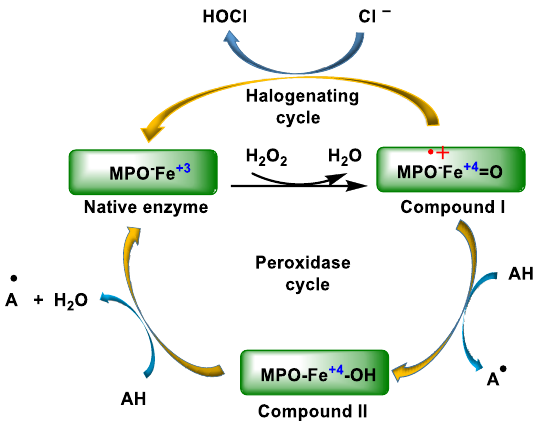
Figure 3. Normal catalytic cycling of myeloperoxidase. The native state of the enzyme, ferric MPO, reacts with hydrogen peroxide to form the redox intermediate Compound I. Compound I oxidises chloride to regenerate ferric MPO via the halogenation cycle.